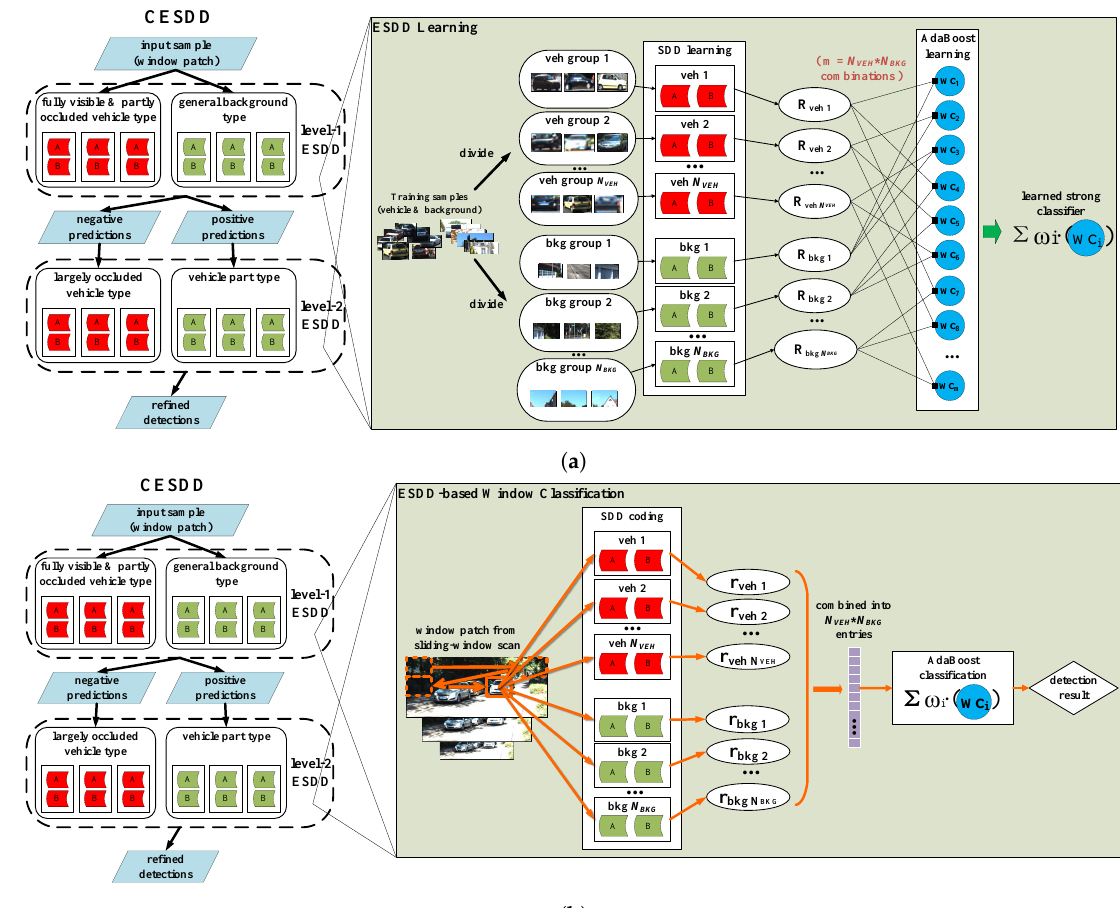
Figure 1. Flowcharts of training CESDD ( a ) and detection with CESDD ( b ). ( a ) Training of CESDD. All sparse-and-dense dictionaries (SDDs) of both levels in the cascade are obtained through ESDD learning: training samples are firstly grouped into subcategories; then the SDD ensemble is learned with one pair of dictionaries (A, B) for each subcategory; next, downstream AdaBoost classifier is learned from the residue combinations from the ESDD; ( b ) Detection with CESDD. Through levels in the cascade, ESDD-based window classification is performed: a window patch from sliding-window scan process is passed to each SDD in the ensemble for coding, and the resulting reconstruction residues are then transformed into the input to the downstream AdaBoost classifier to give prediction.